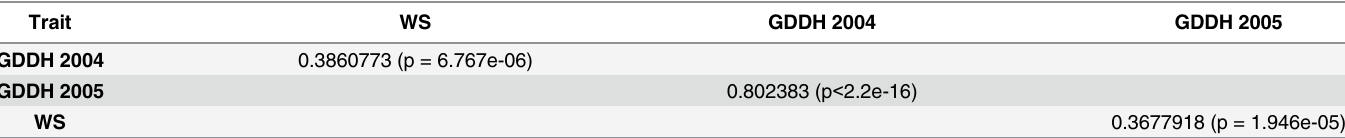
Table 3. Spearman ’ s rank correlation coefficient for the traits winter survival (WS) and heading date expressed as growing degree-days to heading (GDDH 2004 and GDDH 2005). Trait